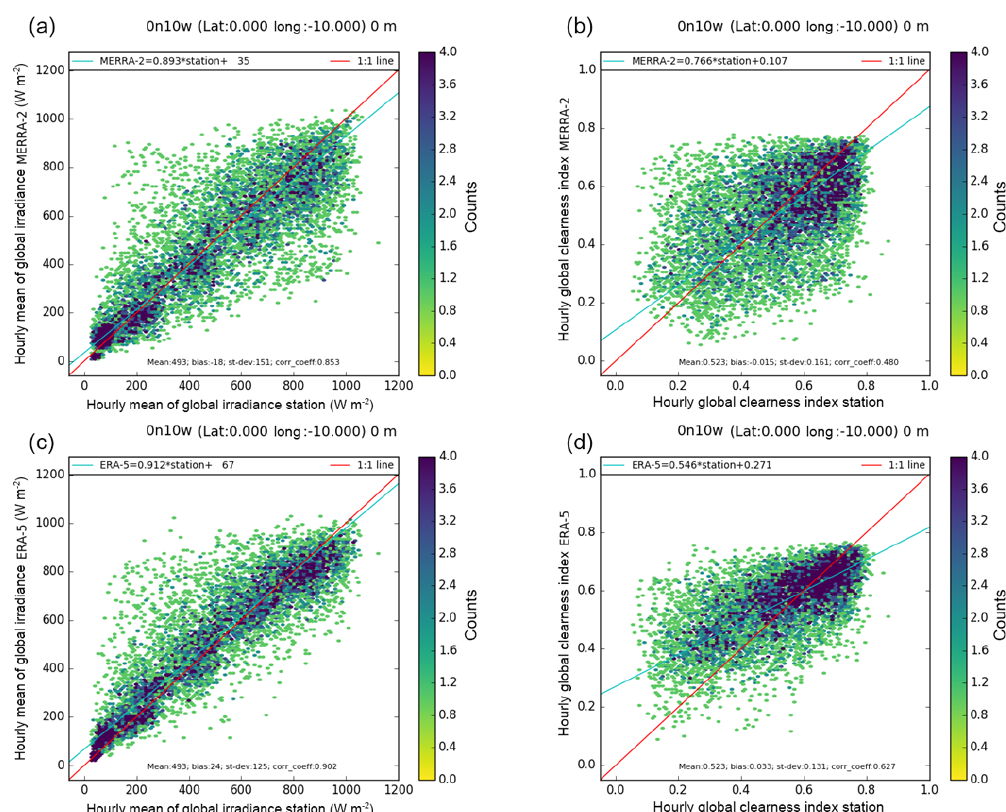
Figure B4. The 2-D histograms of PIRATA measurements (horizontal axis) and data sets (vertical axis) at 0 ◦ N, 10 ◦ W for E and KT. MERRA-2: (a) and (b) ; ERA5: (c) and (d) . Ideally, the dots should lie along the red line (1:1 line). The blue line is the affine function fitted over the points and should ideally overlay the red line.